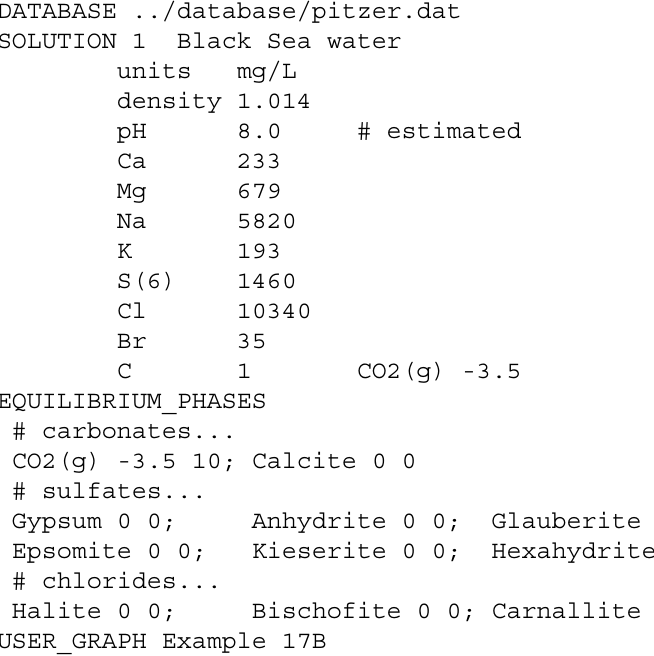
Table 51. Input file for example